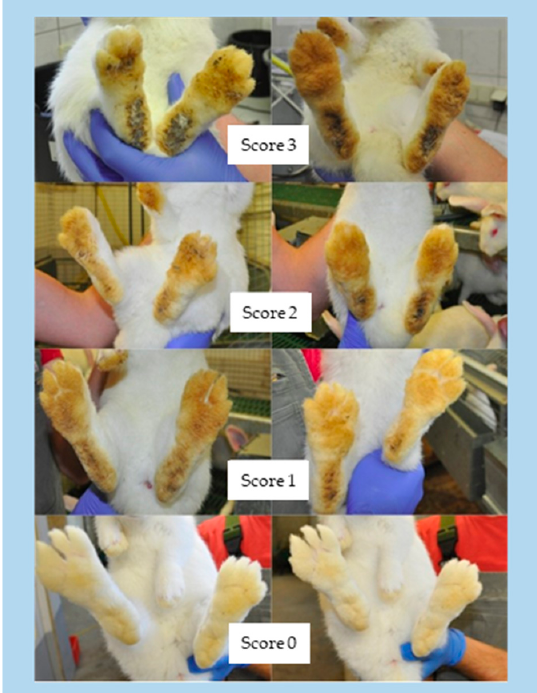
Figure 5. Pollution rating scheme with score 0 = clean to score 3 = heavily polluted.